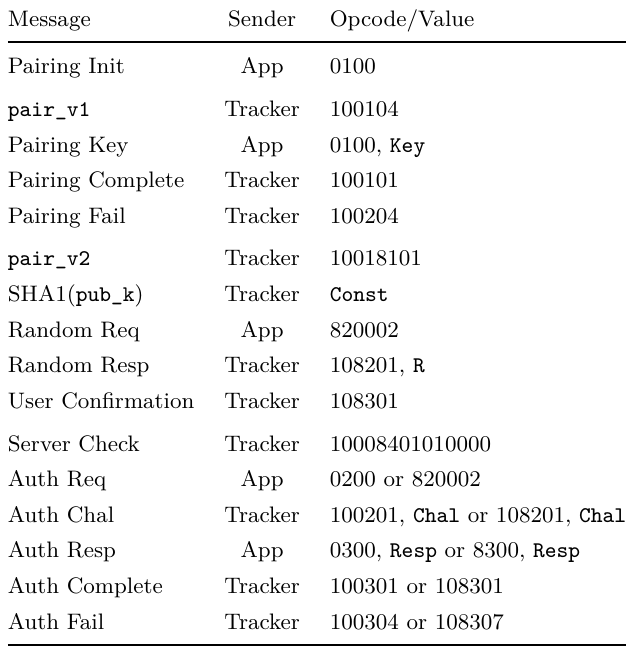
Table 2: Reversed Xiaomi application-layer opcodes and relevant values. Key , Const , R , Chal and Resp are 16-byte values shown in hex. Const equals to 1863c2cce5d159413bed92c4b163c279